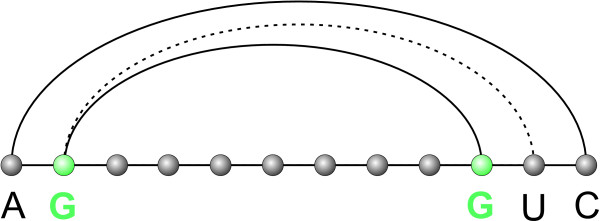
Incompatible structures. We display a perturbation of the dotted arc leading to a structure that is incompatible to the given sequence.